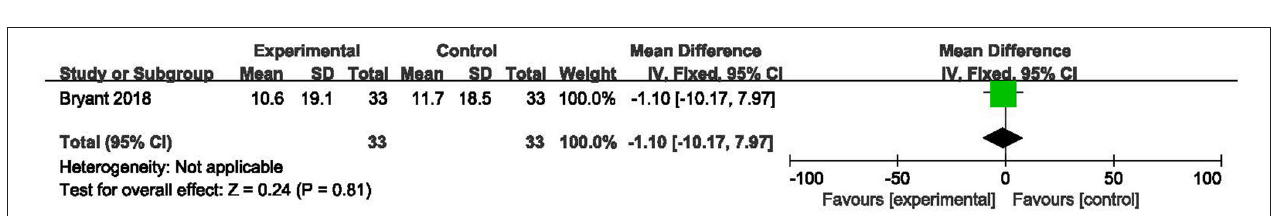
FIGURE 8 | Forest plot of network meta-analysis of the end-of-treatment effect on depression severity between cognitive behavioral therapy-long and cognitive behavioral